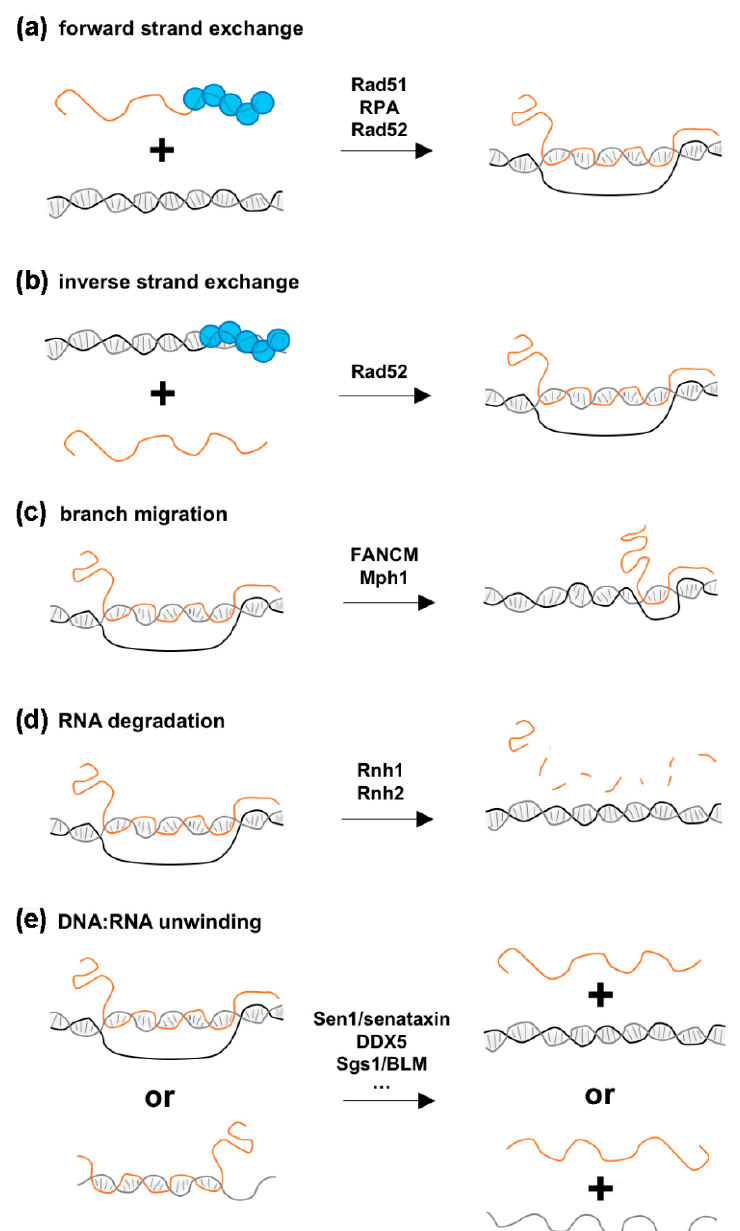
Figure 2. An overview of the enzymatic reactions engaging RNA-containing structures. Examples of enzymes reported to catalyze the indicated reactions are listed, and their respective substrates and products are represented for forward and inverse strand exchange ( a , b ), branch migration ( c ), RNA degradation ( d ) and DNA:RNA unwinding ( e ). Note that RNase H2 can also excise ribonucleotides and degrade short RNA primers embedded within the genome.